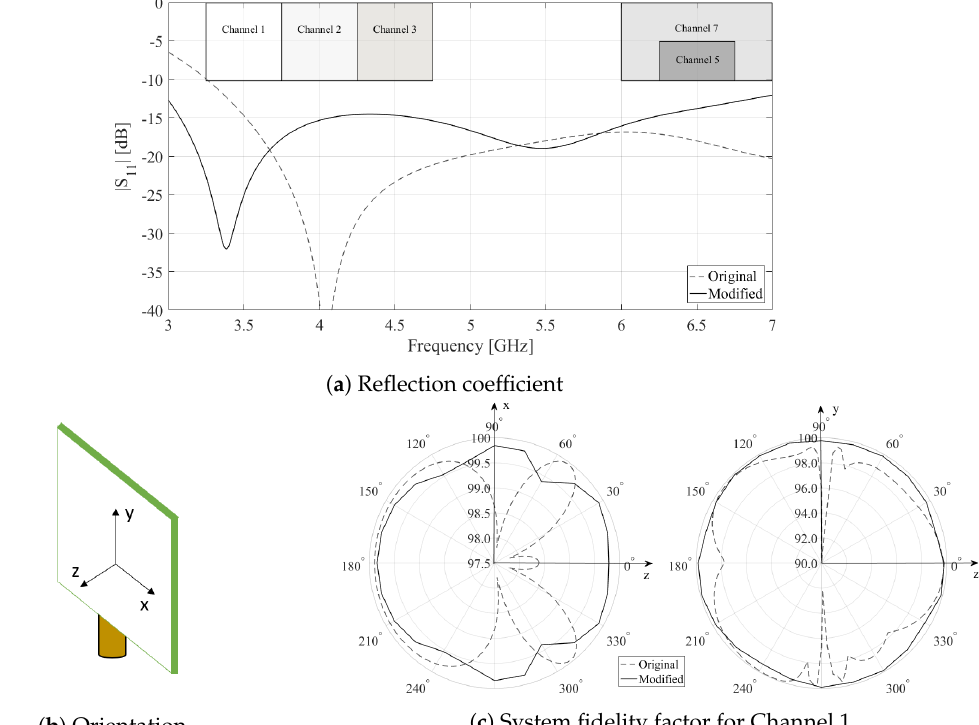
Figure 2. Comparison between the standard monopole antenna proposed by Decawave and the modified